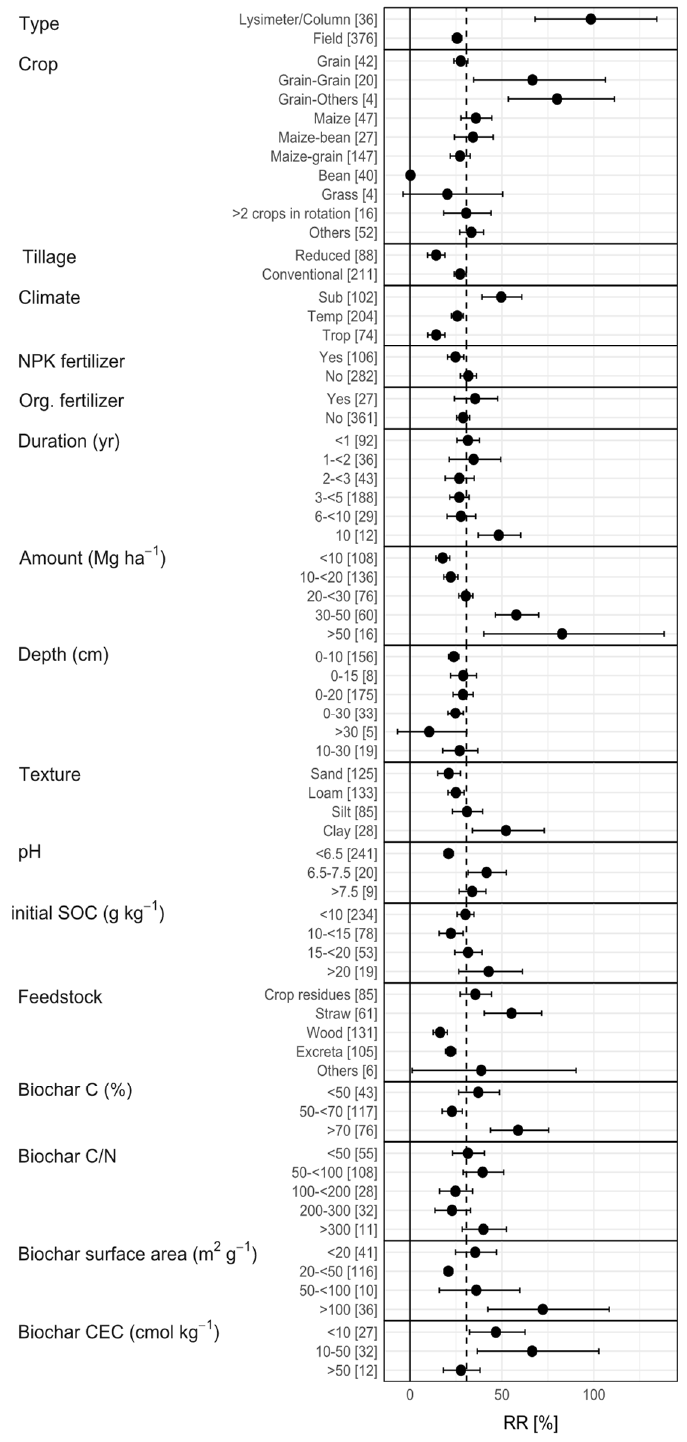
Figure 2. Meta-analysis results of the “field-dataset”, given as forest plot. Presented is the relative change of soil organic carbon stocks (RR [%] ) after biochar application influenced by different data groups. Numbers in brackets represent the number of included treatments. Points within the range represent the mean dSOC and the line within the 95% confidence interval represents the range of the effect size. If the effect size range crosses the “zero-effect-line”, given as a solid vertical line at 0%, the result can be interpreted as statistically insignificant. The effect sizes of each group were considered to be significantly different at p < 0.05 from each other if the 95% confidence intervals were not overlapping. The vertical dotted line represents the grand overall